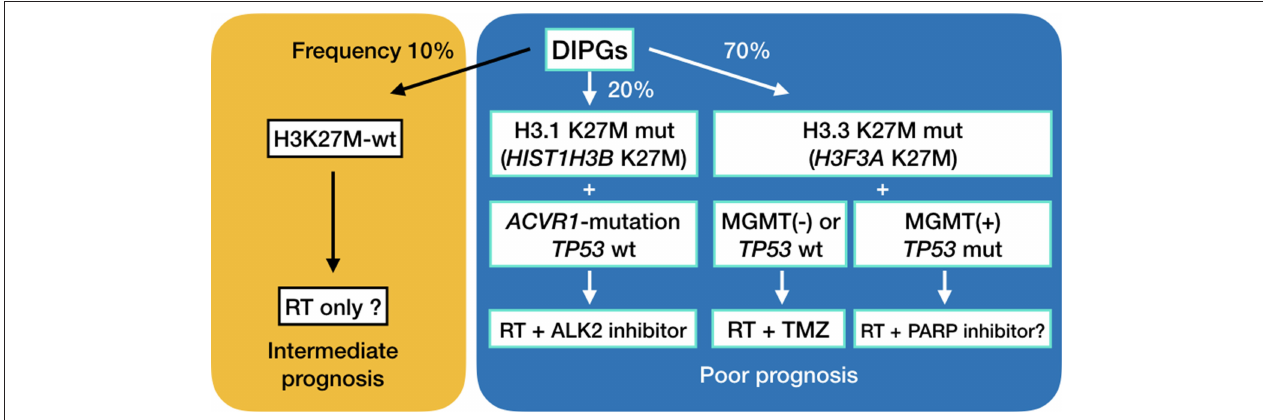
FIGURE 5 | Suggested treatment for diffuse midline